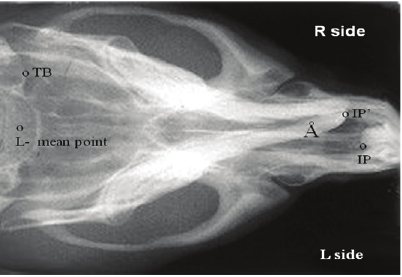
FIGURE 1 - Axial radiograph of the skull. TB = tympanic bulla, IP = incisal point of maxilla, IP’ = incisal point of mandible, L = medial point, Å =